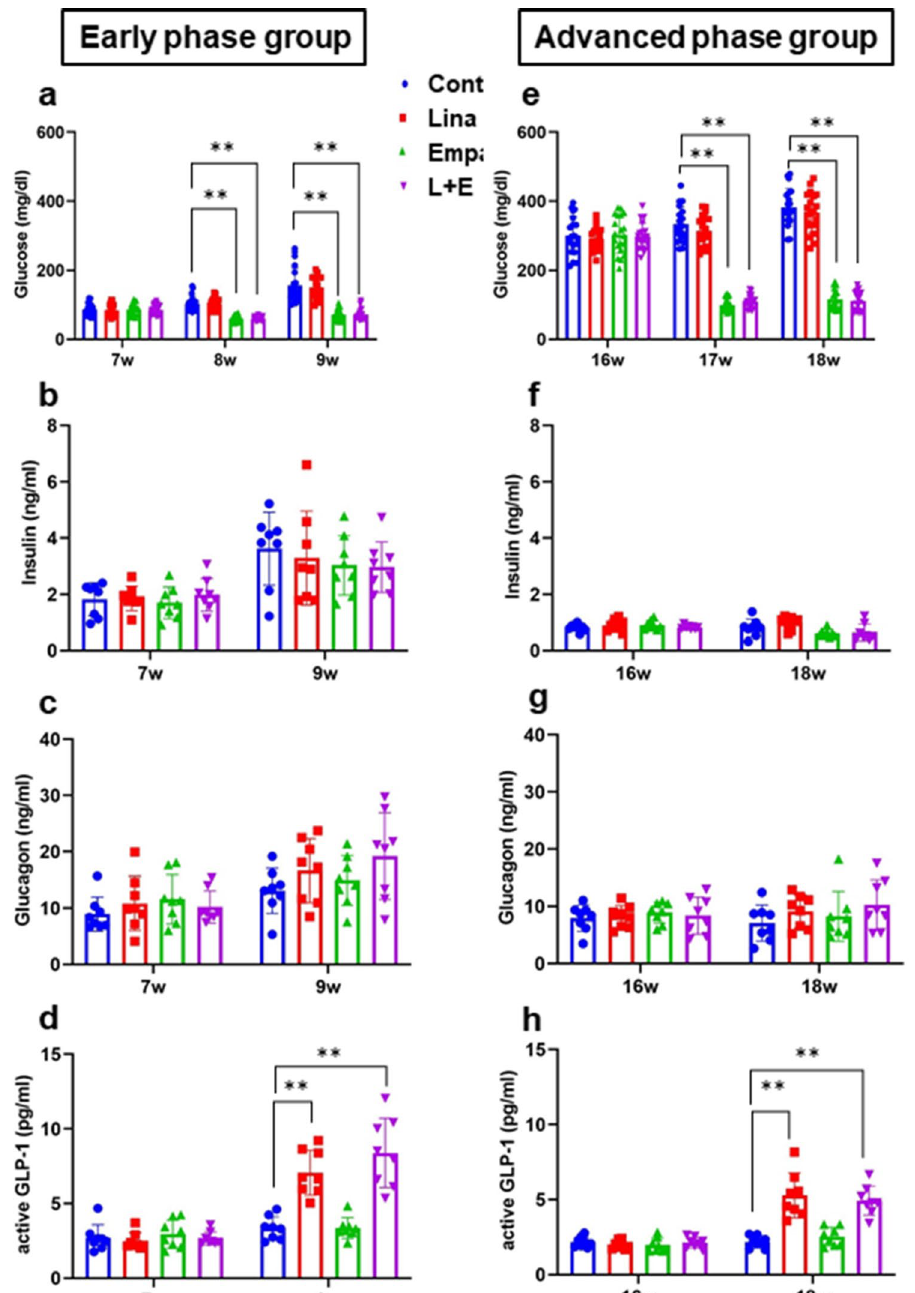
Figure 1. db/db mice in an early (7–9 weeks) and advanced (16–18 weeks) phase of diabetes treated with 0.5% carboxymethylcellulose (Cont: blue circle), linagligtin (Lina: red square), empagliflozin (Empa: green triangle), and combination of linagliptin + empagliflozin (L + E: purple reverse triangle) for 2 weeks. ( a , e ) Blood glucose levels (n = 20), ( b , f ) serum insulin levels (n = 8), ( c , g ) glucagon levels (n = 8), ( d , h ) active GLP-1 levels (n = 8). The multiple comparison was performed using the Tukey–Kramer method. Data are presented as mean ± S.D. **: p <